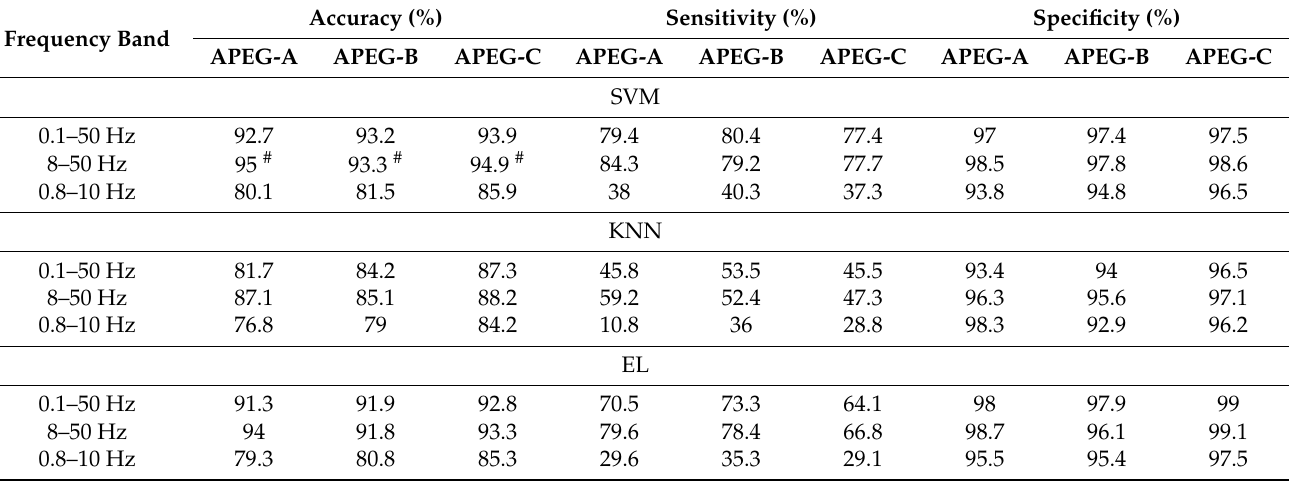
Table 6. Five-fold cross-validation classification performance using a 10 s time window for